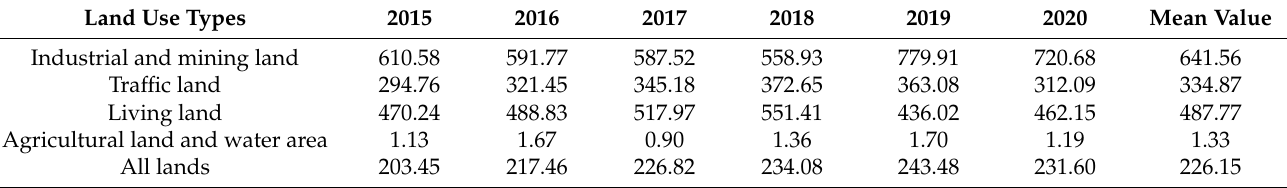
Table 2. Carbon density (t/ha) on different types of land during